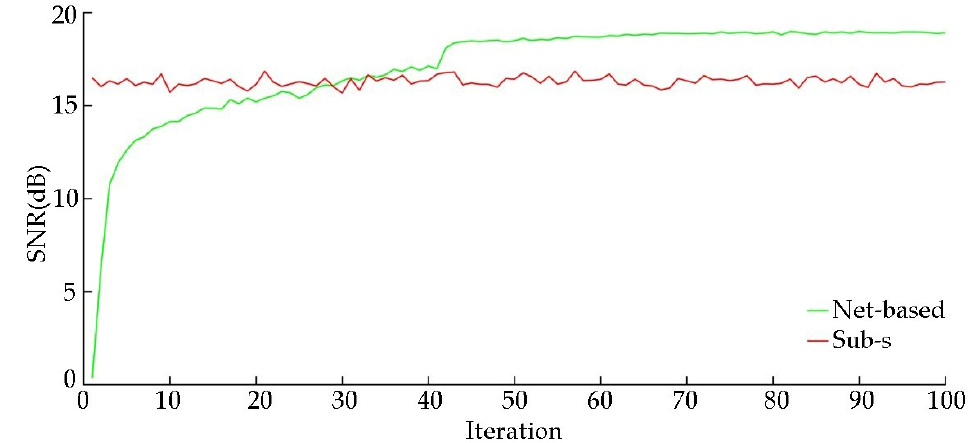
Figure 9. The SNR of the reconstructed spectrum with the iterations number of the network.